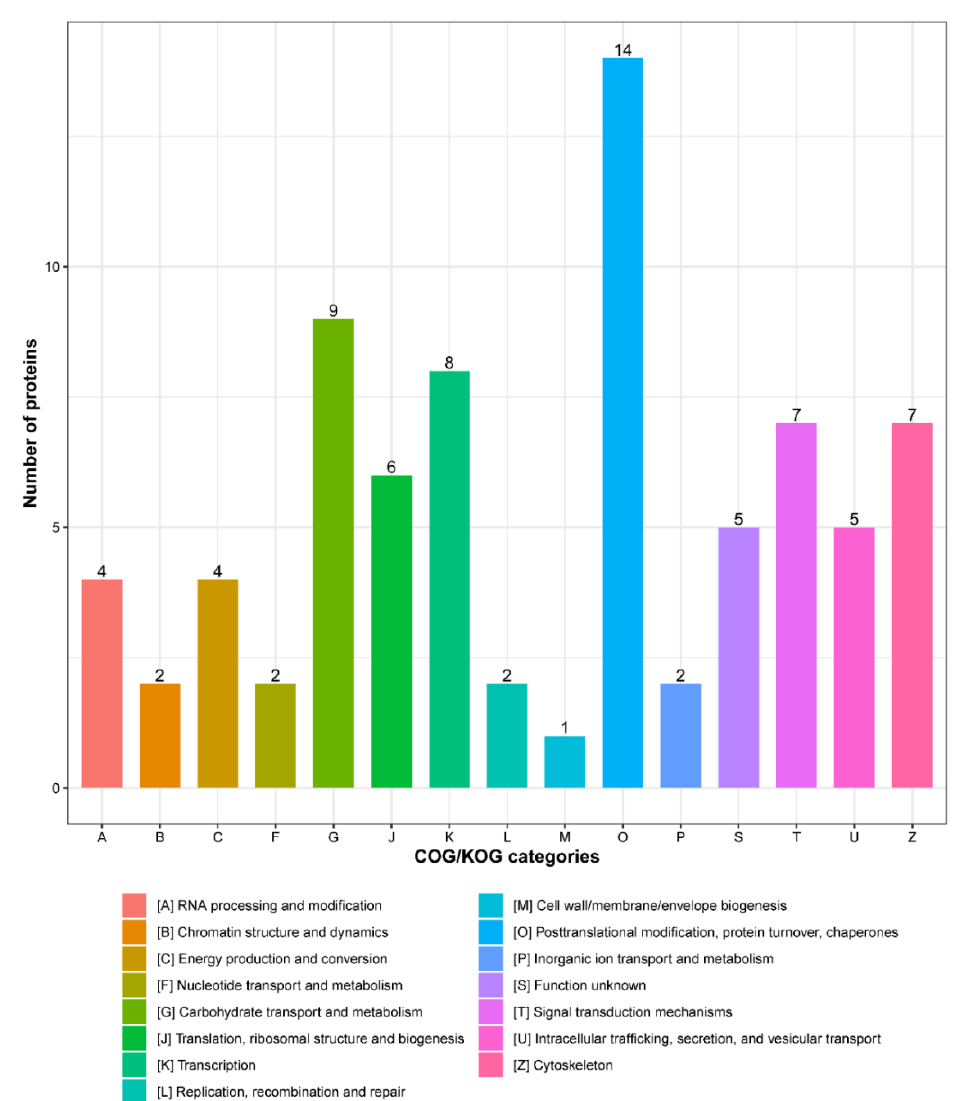
Figure 4. Clusters of Orthologous Groups (COG) functional classification of interferon-stimulated gene product 15 (ISG15)-conjugated proteins.